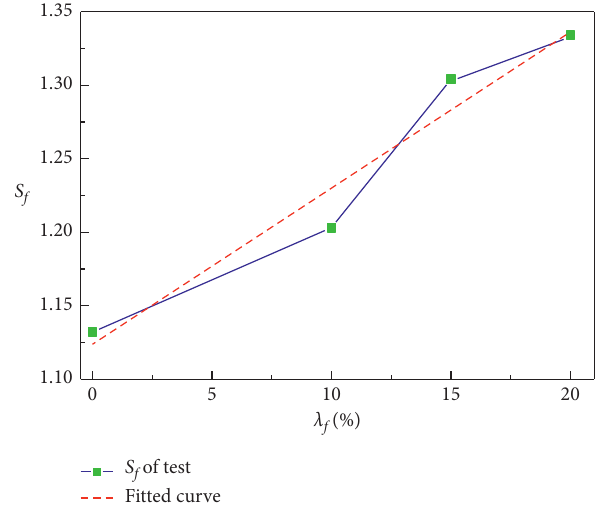
Figure 9: Relationship between the proportion of the fine fiber and S